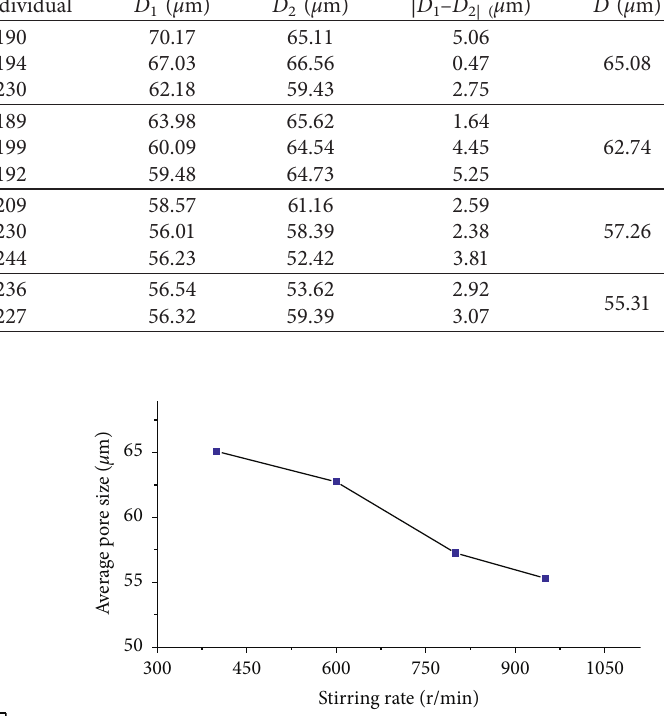
Figure 16: Average aperture and stirring rate